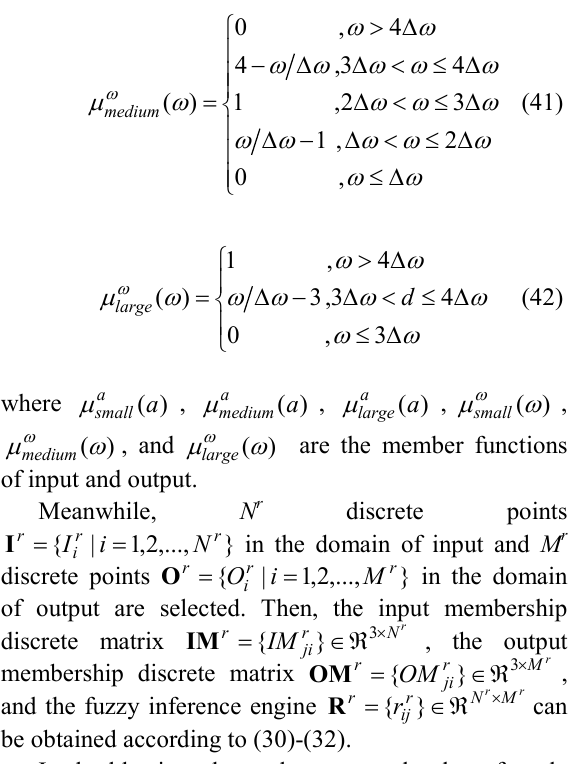
Fig. 9. Frame of proposed